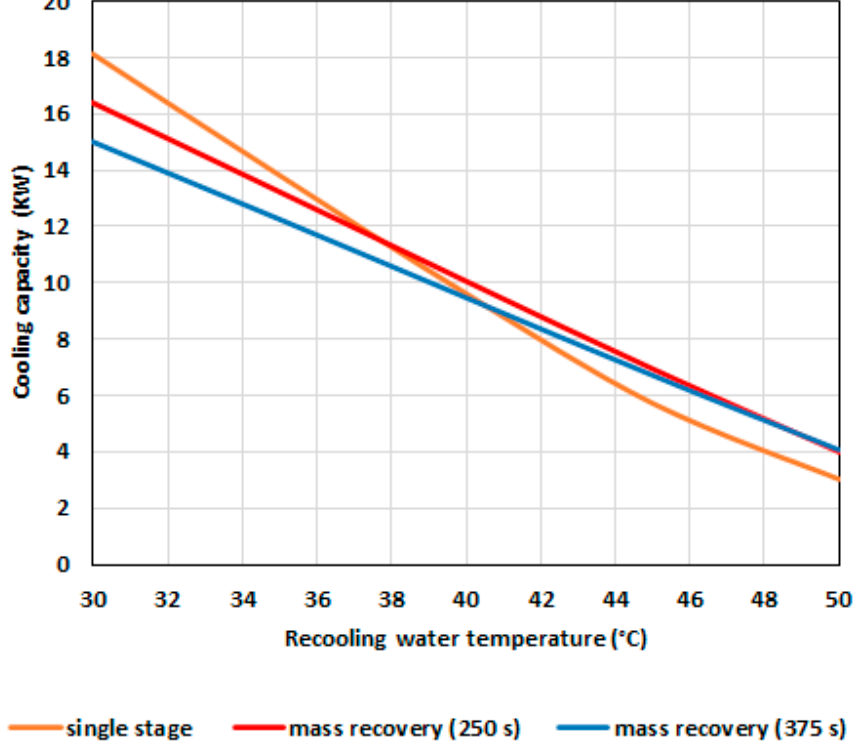
Figure 15. Predicted cooling capacity with various mass recovery times and recooling water tem- peratures.